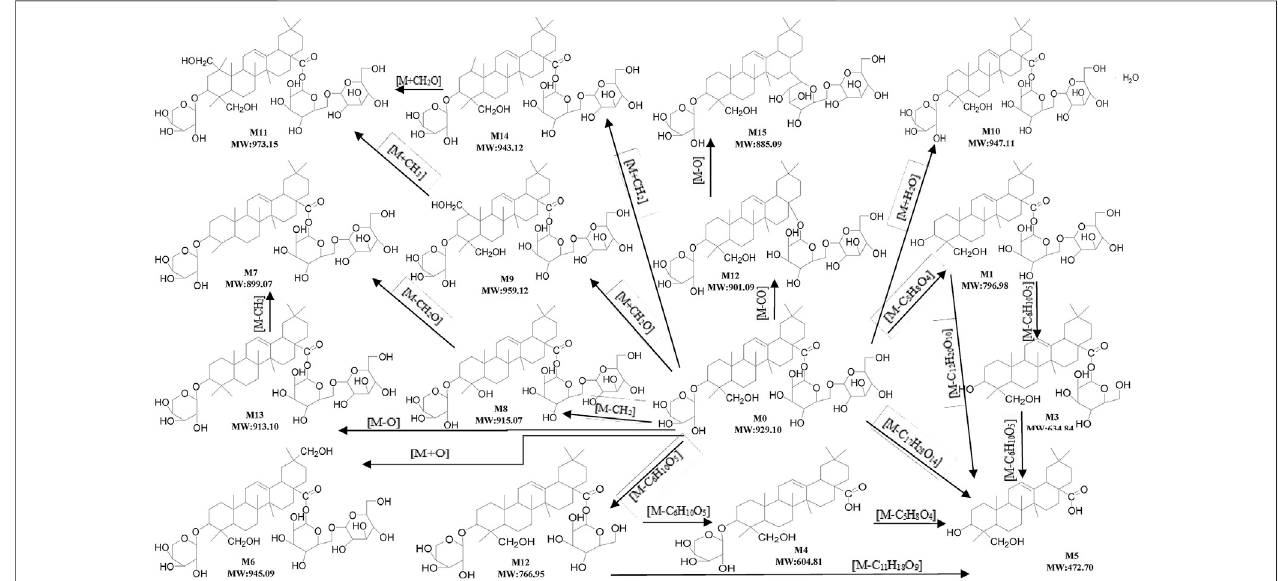
FIGURE 7 | Proposed metabolic pathways of ASD in rat urine, feces and